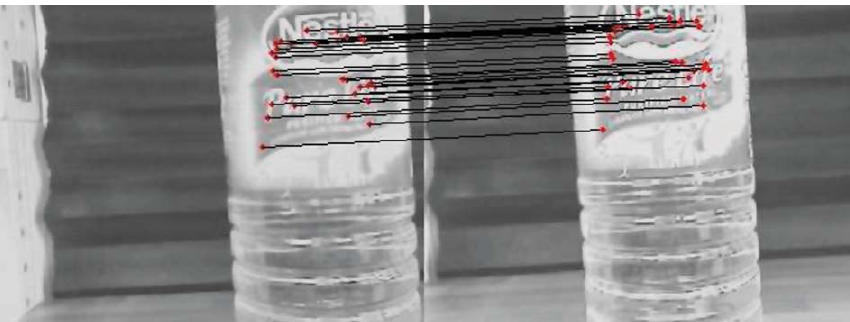
Fig. 5. 3D geometry estimation: initial SIFT descriptors matched between the left and right images of the gripper stereo camera at a distance of twelve inches. Algorithm 2 Estimating Local 3D Geometry